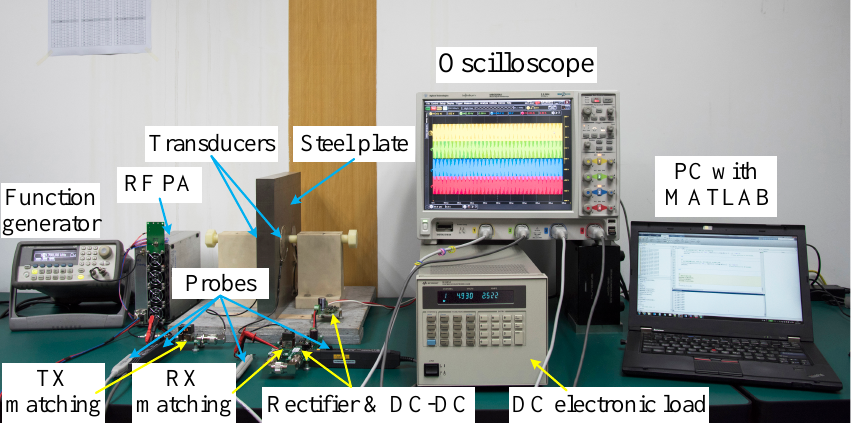
Figure 13. Photo of the system measurement setup.